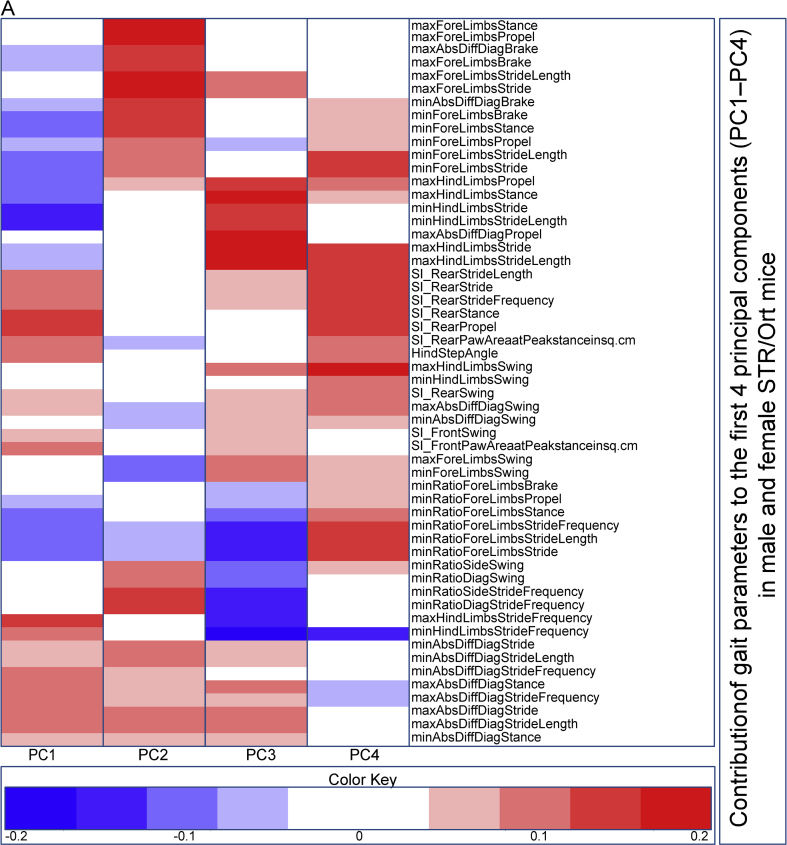
Sexually dimorphic OA development in STR/Ort mice is linked to longitudinal gait asymmetry. (A-B) Heatmaps representing the contribution of the gait parameters to the first 4 principal components (PC1–PC4) in male and female STR/Ort mice.